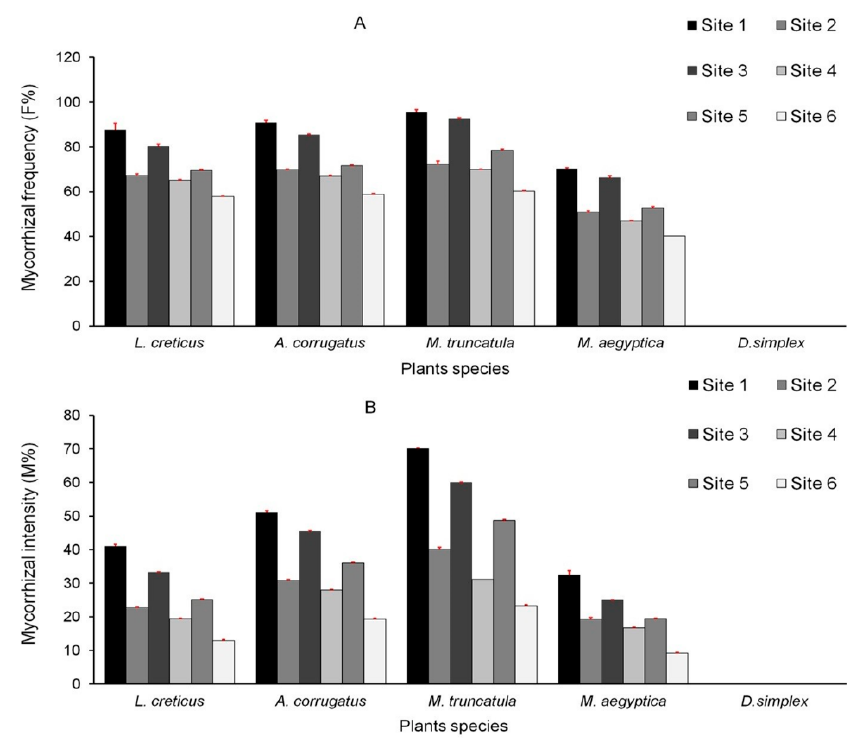
Figure 2. Mycorrhizal frequency ( A ) and Mycorrhizal intensity ( B ) of the five herbaceous plants in the different studied sites. Data are reported as mean (±SE) of three replicates per sample.